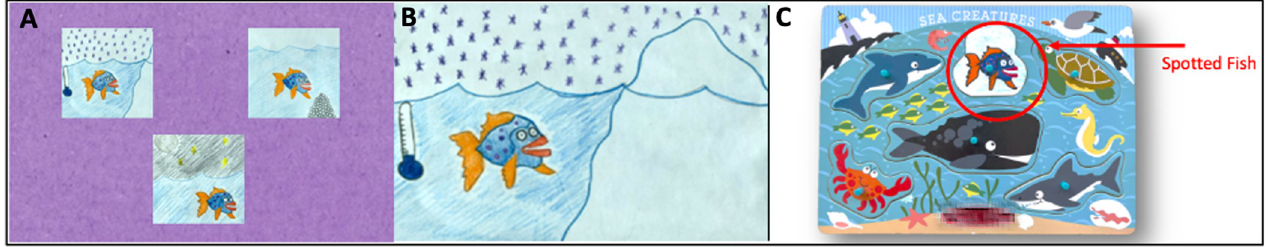
Fig 1. Materials from pilot experiment. Panel A: A cover page of one of the books (about the “Spotted Fish”) used in the learning phase. Cover pages showed all three pieces of information that the book contained. Panel B: One of the pages from the “Spotted Fish” book depicting the piece of information “The Spotted Fish likes cold water.” Panel C: One of the puzzles used in the transmission phase. The original animal puzzle was modified to show the fictional animal (the “Spotted Fish”). Note: A part of the image of the puzzle was intentionally blurred due to copyright restrictions. This figure serves to illustrate the object without depicting it with perfect